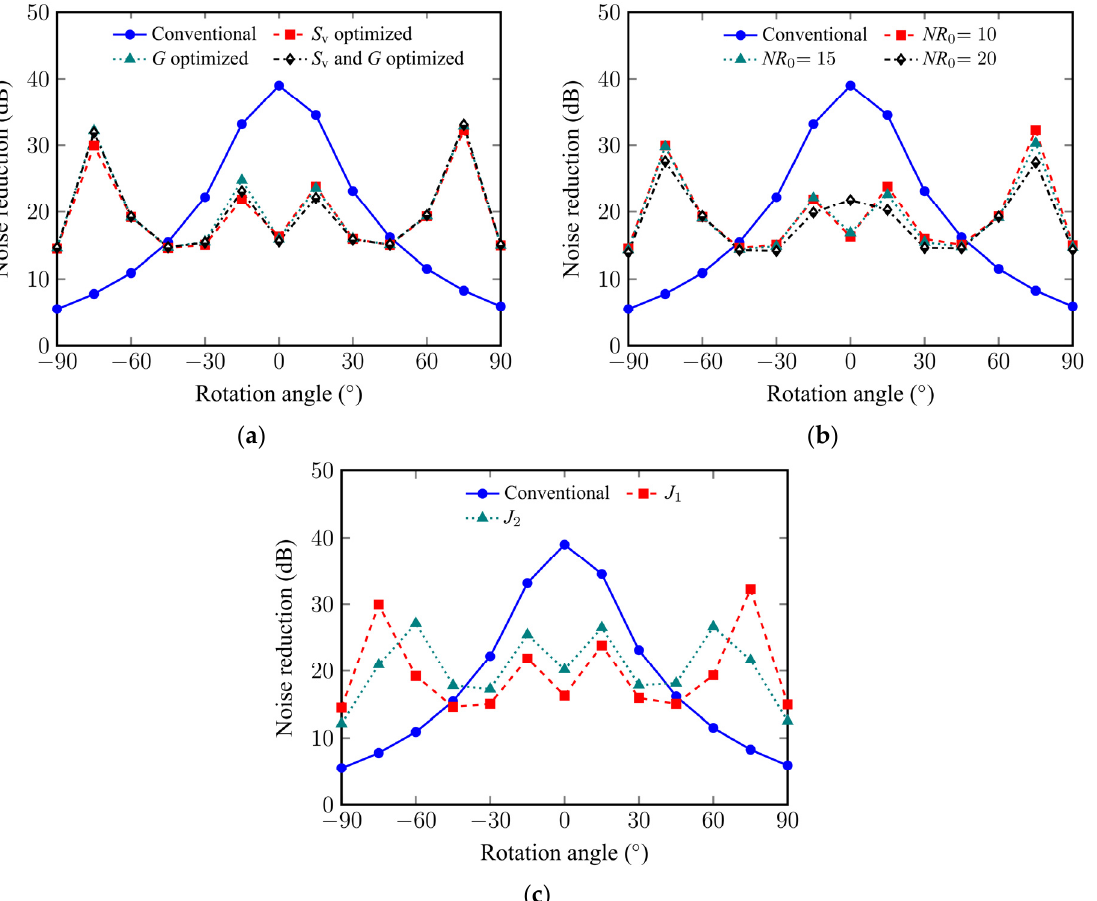
Figure 11. Noise attenuation when head rotates with ( a ) different optimization modes, ( b ) different NR 0 and ( c ) different cost functions.